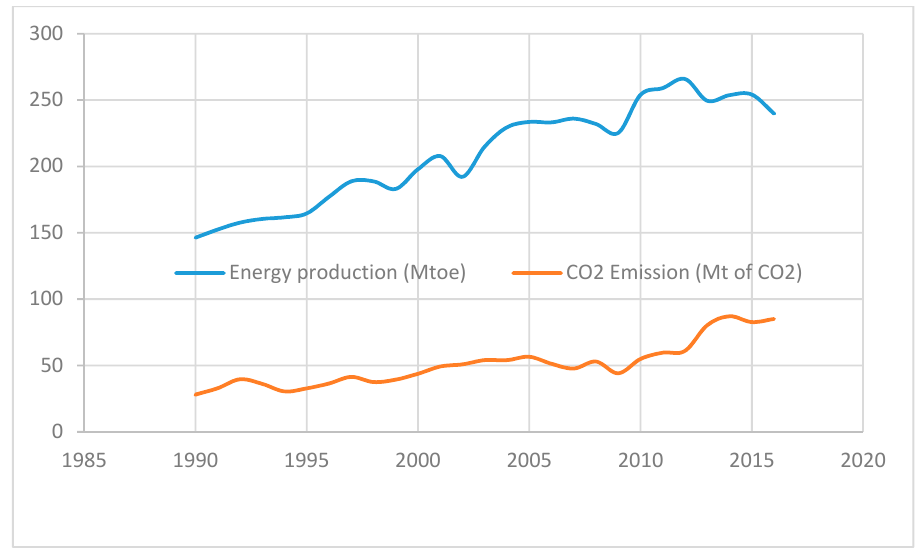
Figure 1. Energy production and CO 2 emissions between 1990 to 2016 in Nigeria (source: [1]).